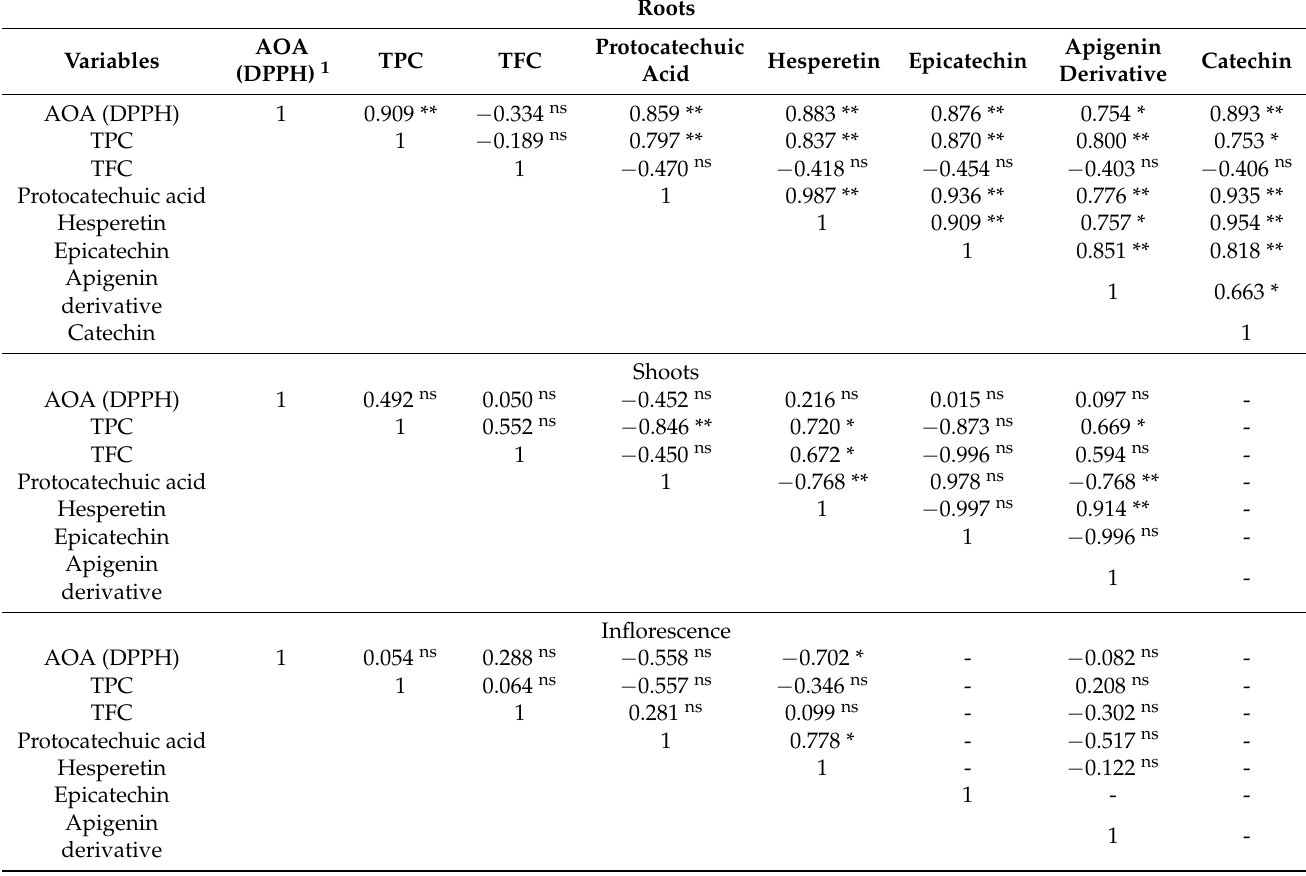
Table 3. Correlation matrix with the Pearson coefficient values for phenolic compounds and the antioxidant activity of S. marina .